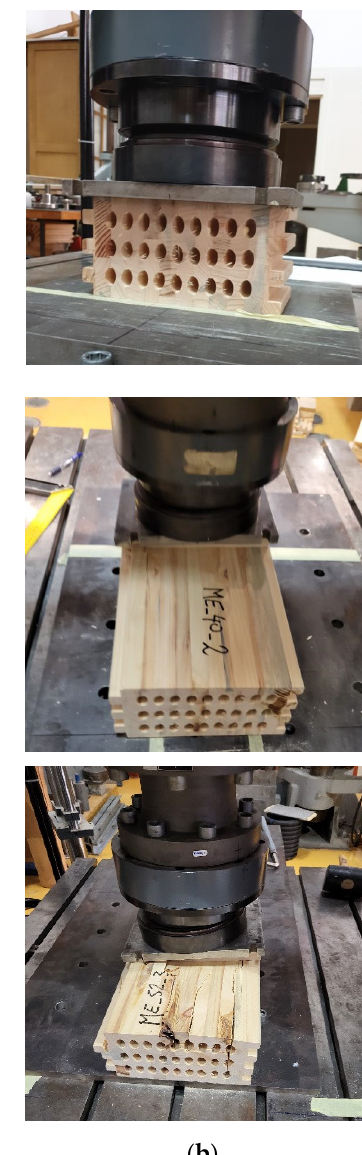
Figure 8. FEM—loading scheme.